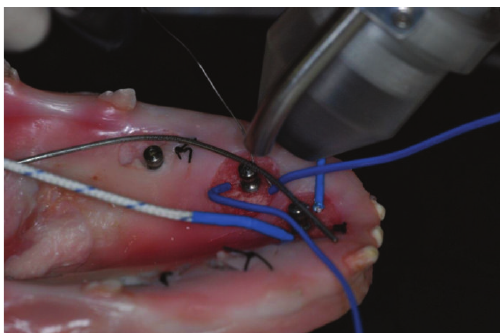
Figure 6: The laser welding